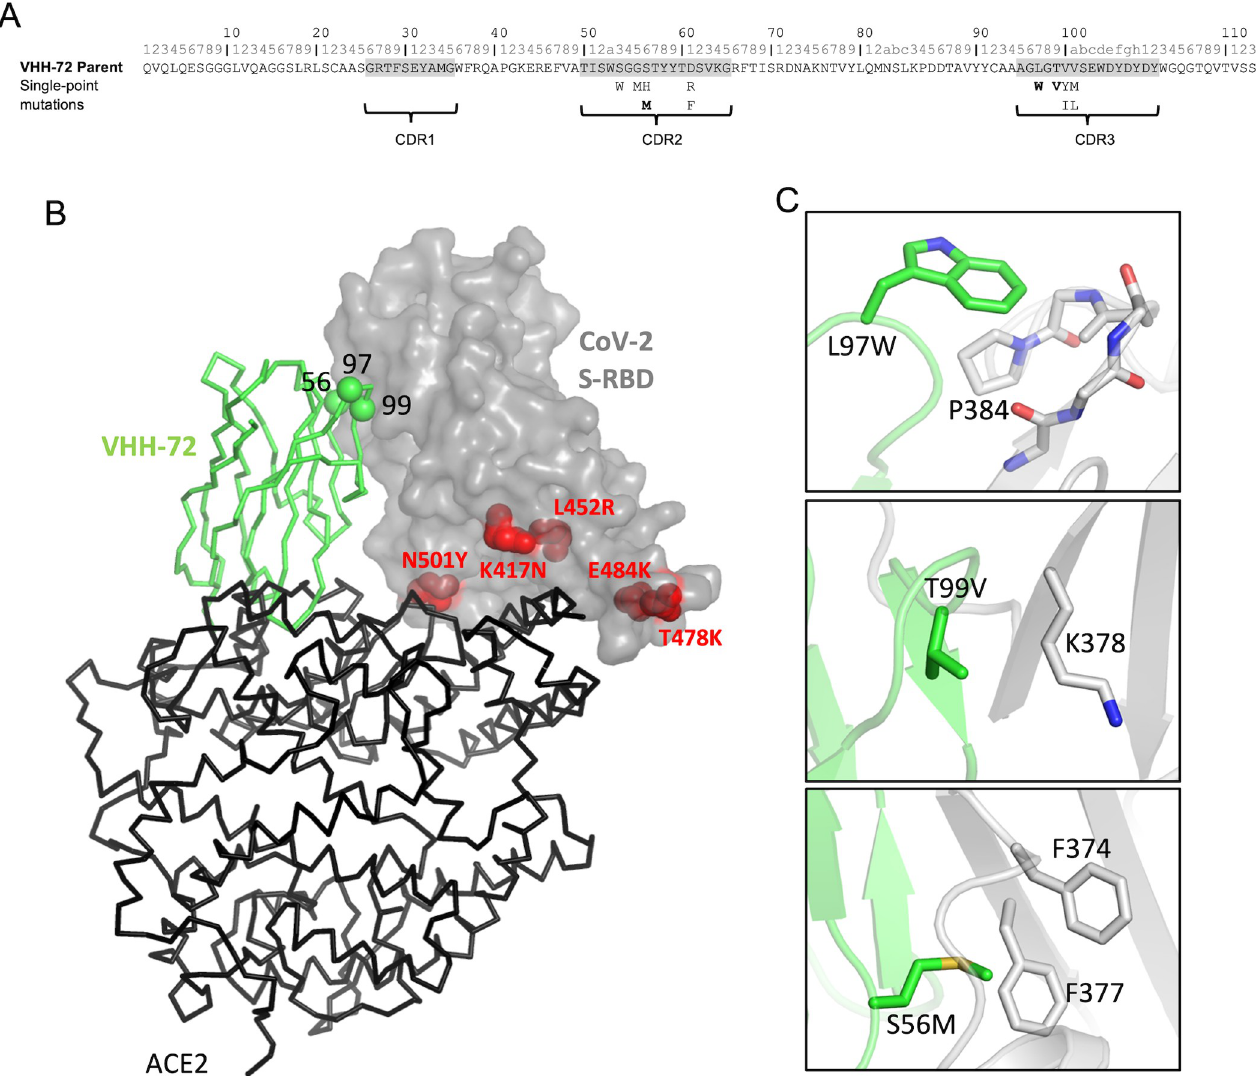
Fig 1. Structural details of designed VHH-72 mutations. ( A ) Sequence mapping of ADAPT-designed 13 single mutations tested experimentally, which are shown under the sequence of the parent VHH-72 (Kabat numbering shown on top). Mutant hits validated experimentally are bolded. ( B ) Structural context of the mutations at the positions corresponding to the 3 single-mutant hits (green C α spheres labeled) of the VHH-72 (green C α trace). Positions of the current SARS-CoV-2 mutations of concern from the B.1.351 (Beta) and B.1.617.2 (Delta) virus variants are rendered as red CPK models and labeled on the SARS-CoV- 2 Wuhan spike-RBD (gray surface). The relative position of the ACE2 receptor ectodomain (black C α trace) bound to the SARS-CoV-2 S RBD is taken form PDB entry 6M17. The steric clash between VHH-72 and ACE2 leading to their mutual exclusion when bound to S RBD is apparent from this superposition. ( C ) Detailed interactions at the three designed mutation sites. VHH-72 rendering is in green cartoon and C atoms, S RBD rendering is in gray cartoon and C